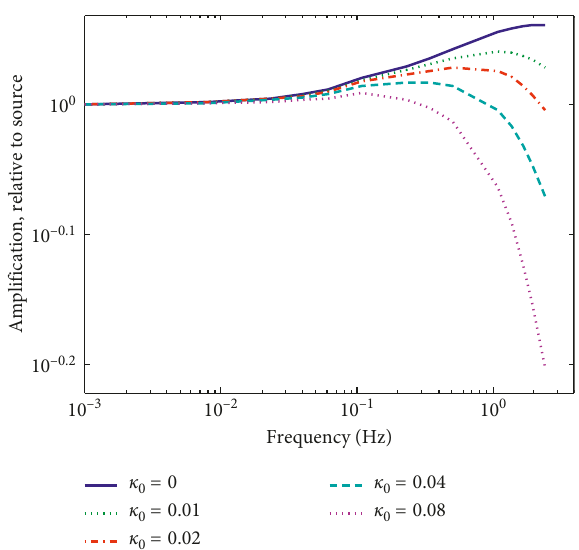
Figure 4: Site amplification combined effect of path-independent diminution. Table 1: Historical earthquake records near the NPP site ( M